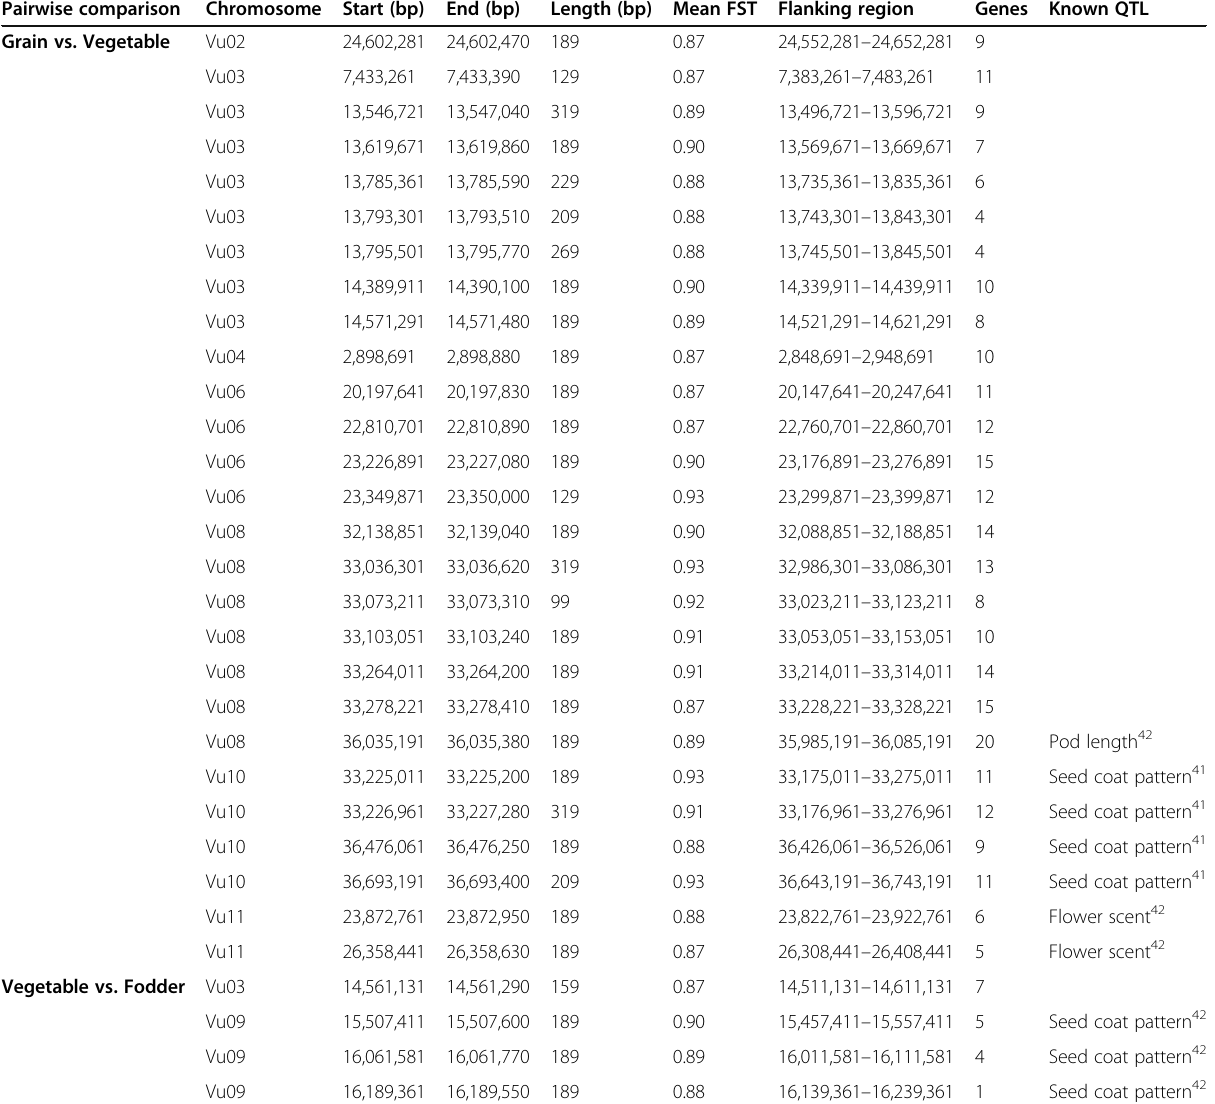
Table footnote: Flanking regions, candidate genes, and known QTLs are shown among different subspecies of cowpea. Columns start, end and length correspond to the peaks of divergence, mapped according to the midpoints of consecutive outlier windows, while the flanking region corresponds to the entire 100kb flanking window surrounding the peak of divergence. The gene search is carried out in the